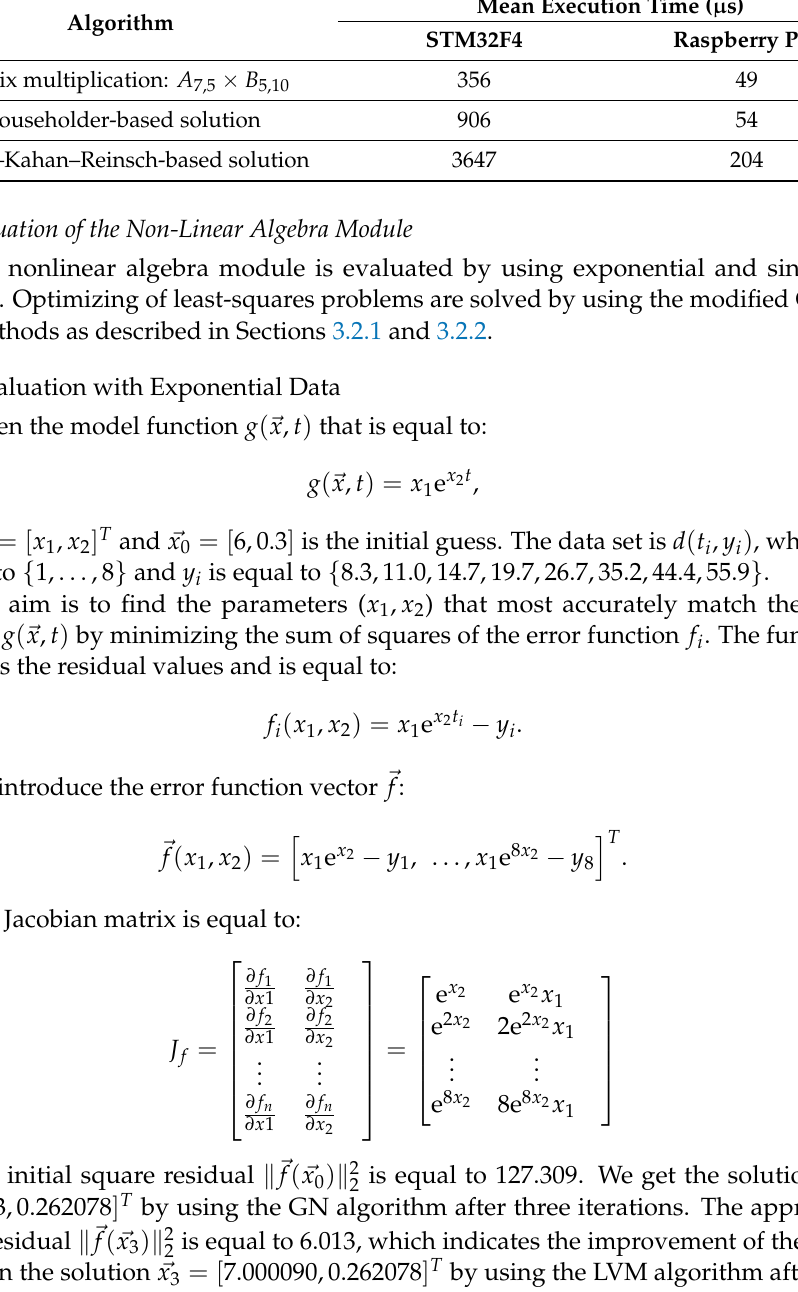
B 5,10 or solving an ( 7,5 ) linear equation system. ×